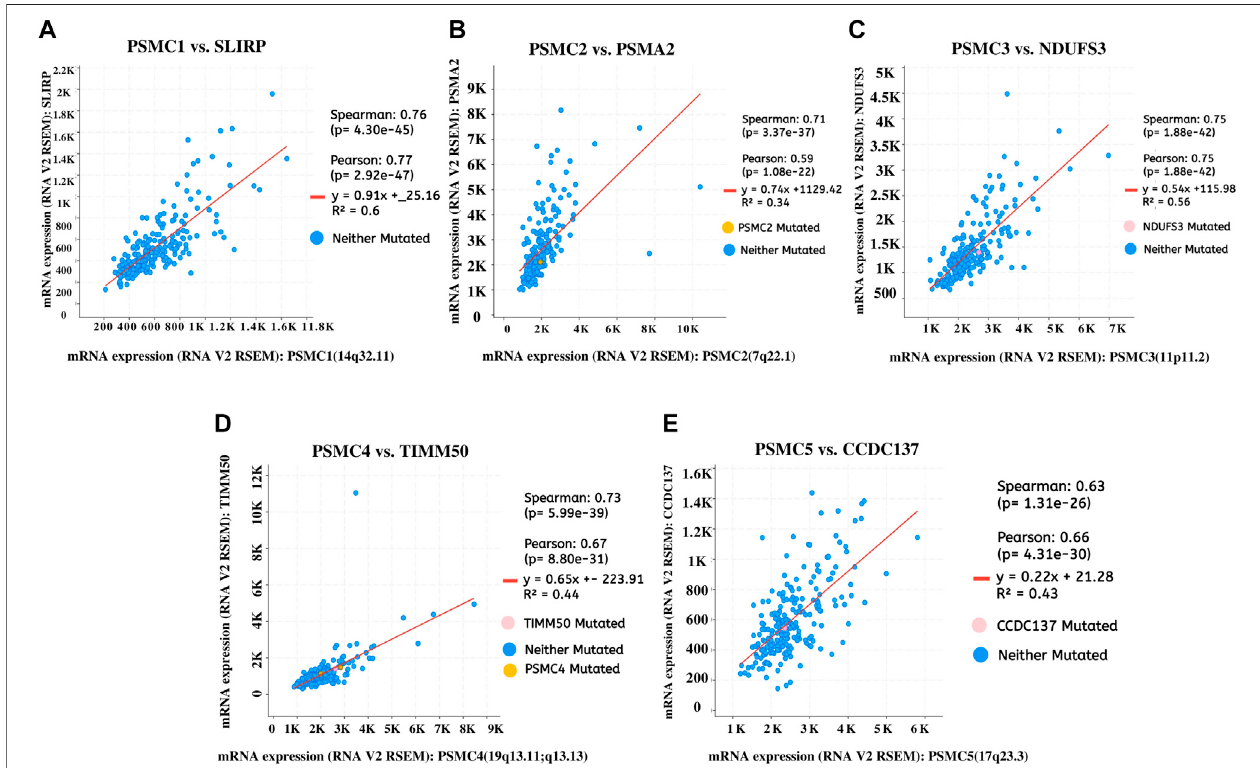
FIGURE 9 | Top positively co-expressed genes of PSMC1 (A) , PSMC2 (B) , PSMC3 (C) , PSMC4 (D) , and PSMC5 (E) in LUAD tissues obtained from the TCGA LUADstudy(FirehoseLegacy)throughthecBioPortalserver.TheexpressionvalueswerecomparedintheformRNA-seqV2RSEMnormalizedscoresofthesequencing reads. RSEM: RNA-seq by expectation